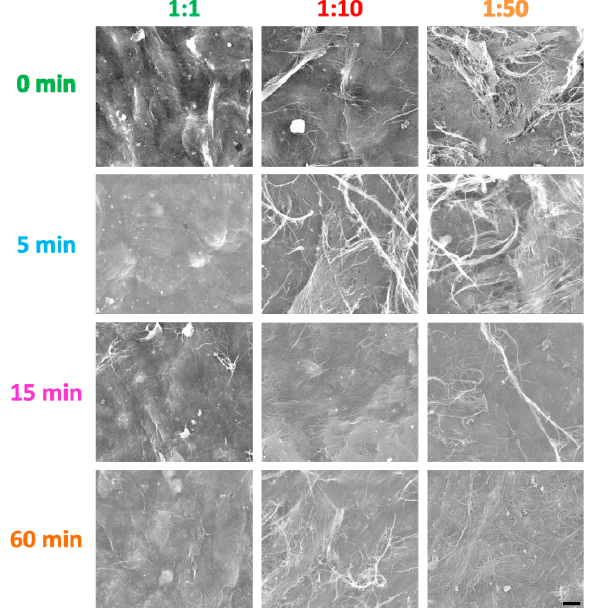
Figure 3. SEM micrographs for all the CNT-EC films made using the same magnification. The black marker is 1 µm long.